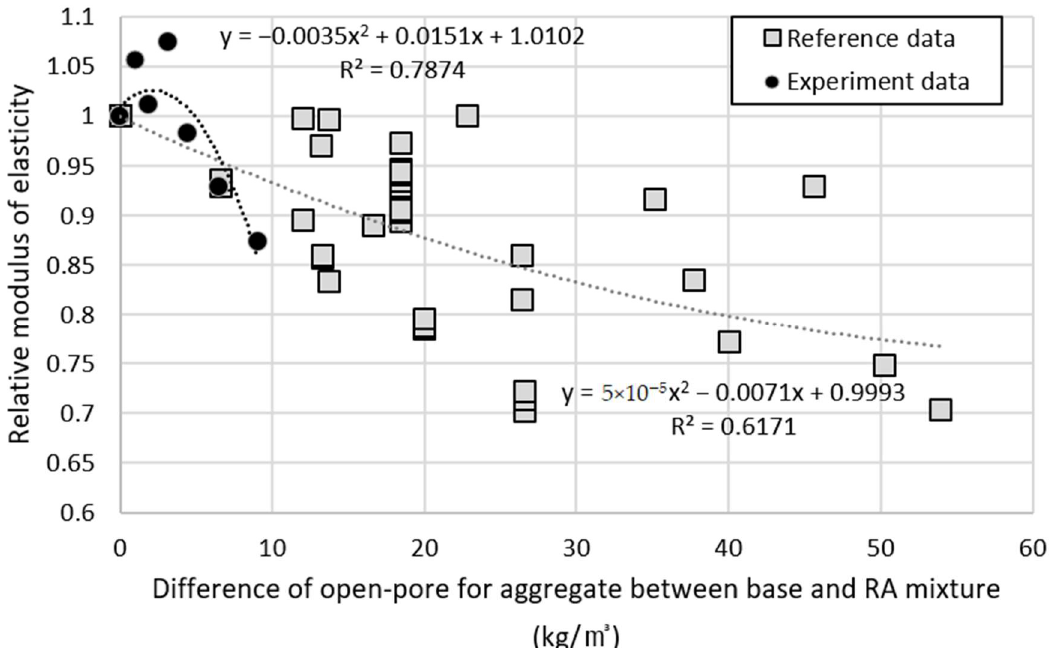
Figure 14. Relative elasticity modulus of basaltic recycled aggregate concrete specimens according to difference of absorption content for aggregate.